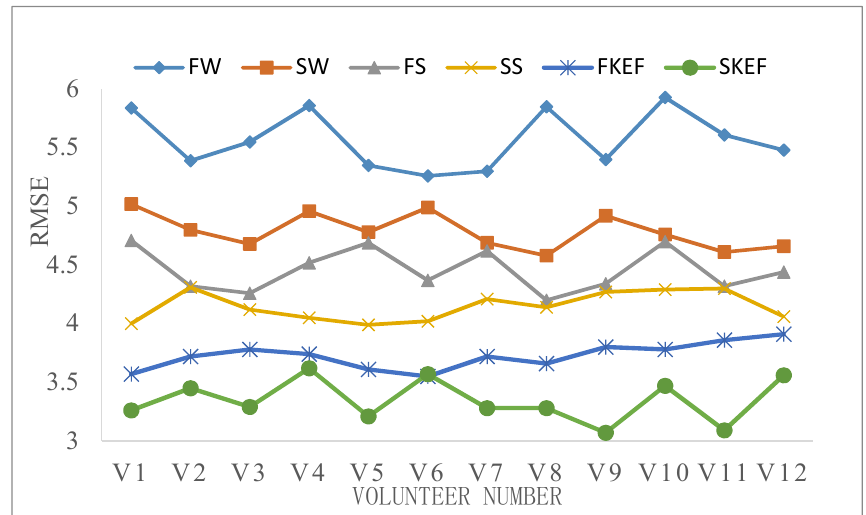
Figure 17. RMSE for each experimental condition of different volunteers.